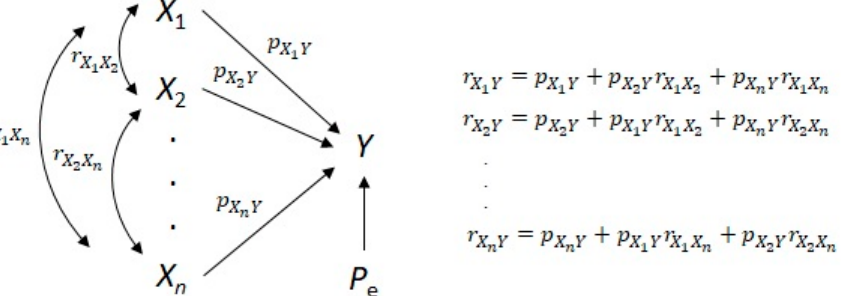
Figure 1. Diagram of path coefficients in the analysis of T. durum milling yield components. Key: Y is the dependent variable (percentage content of bran, flour, and semolina); X i is the independent variable (grain quality parameters, macronutrient, and micronutrient content), where I = 1, 2, . . . n, and n is the number of independent variables; r X is the coefficient of simple correlation between independent variables; r X is the coefficient of simple correlation between independent and dependent variables; p X is the direct effect; p X is the indirect effect; P e is the random effect.